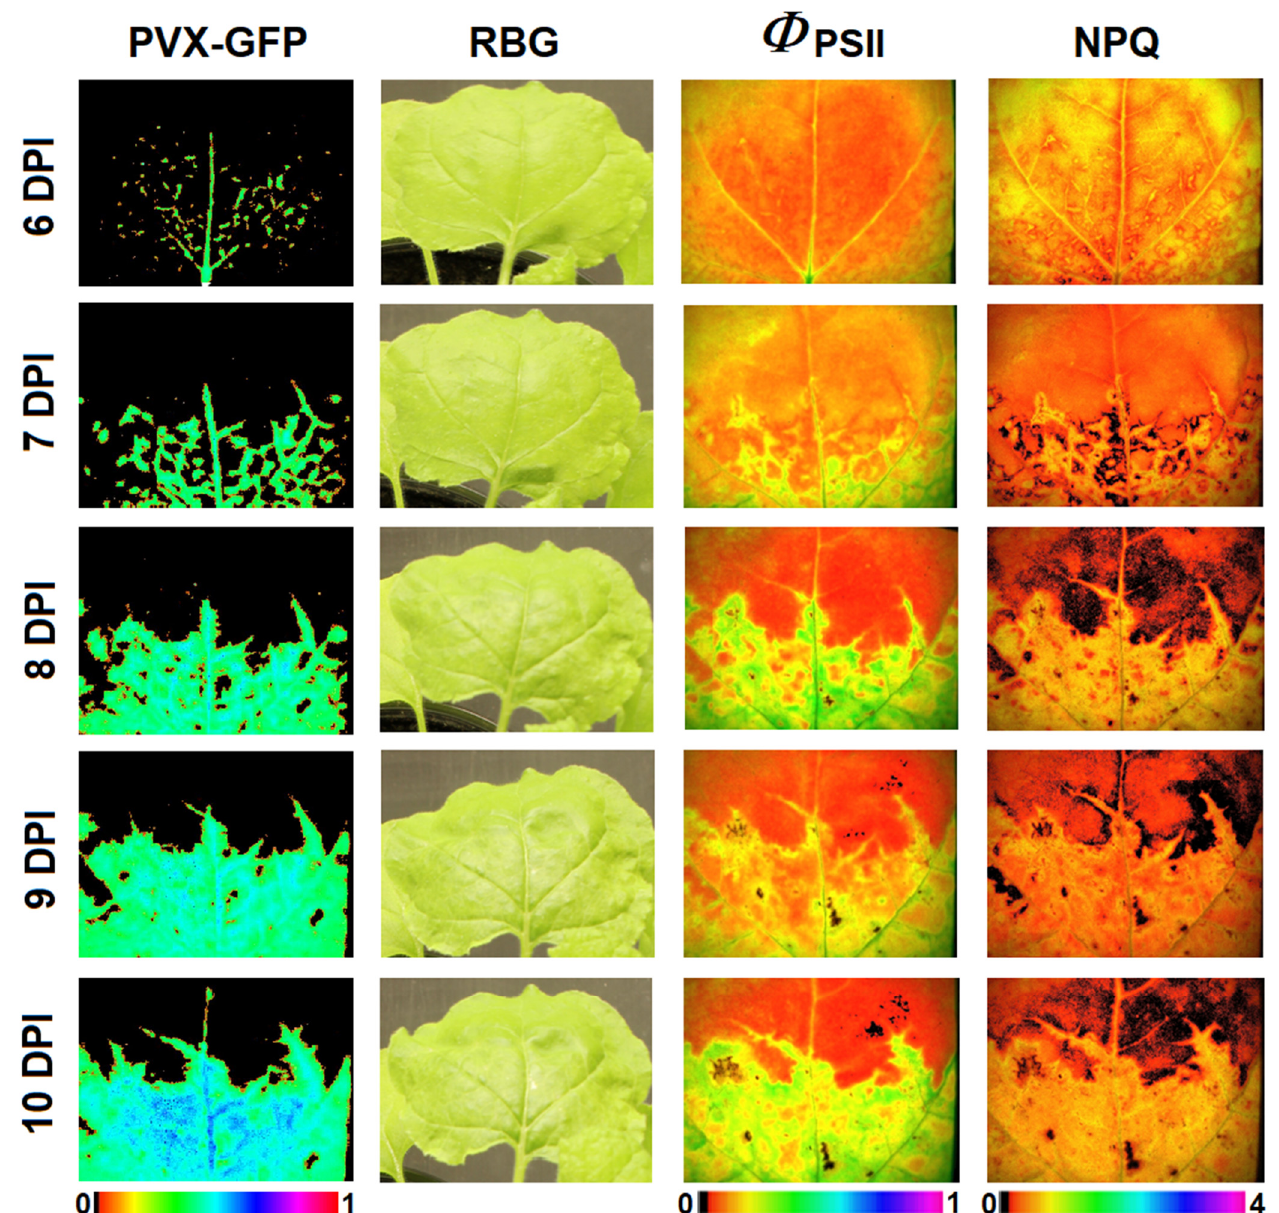
Figure 6. Images of PVX-GFP infected tenth tobacco leaf at various days post-inoculation (DPI): PVX-GFP—fluorescent images ( λ ex 460 nm, λ em 500–540 nm); RGB—RGB images; Φ PSII — Φ PSII images taken 60 s after the AL was switched on; NPQ—NPQ images taken 40 s after the AL was switched on; 6 DPI corresponds to the first day of PVX-GFP detection in the studied leaf.